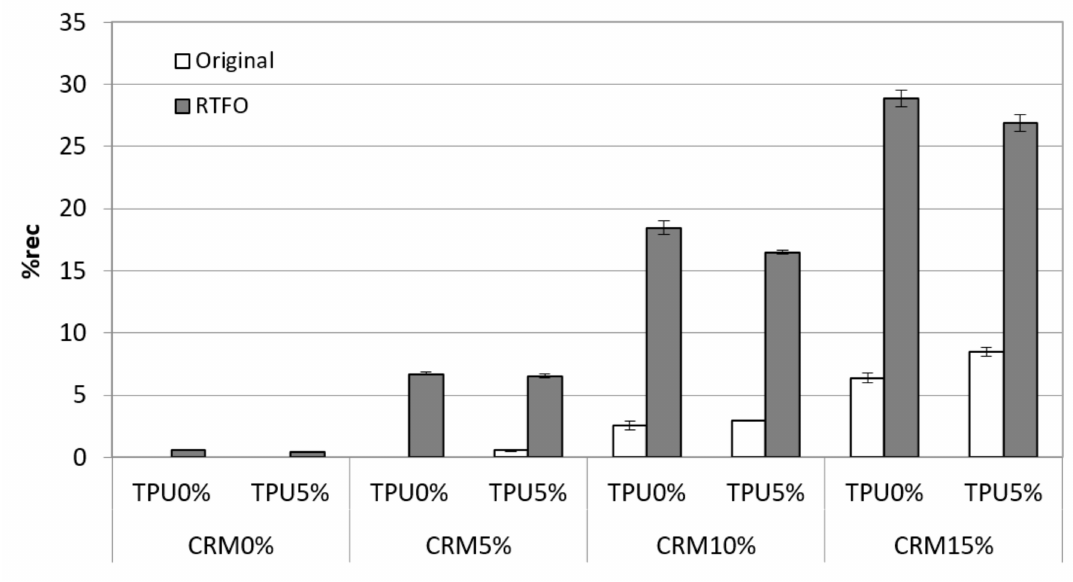
Figure 9. %rec of the CRM asphalt binders containing CRM and TPU for original and RTFO